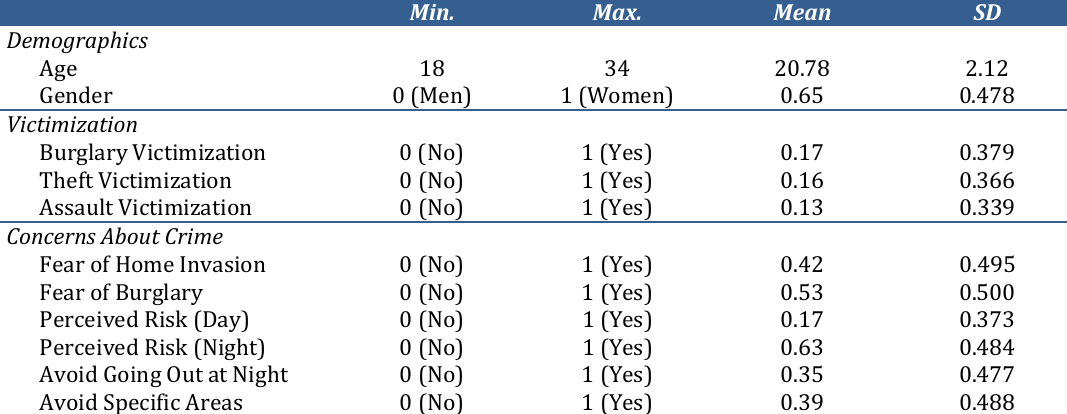
Table 1: Descriptive statistics